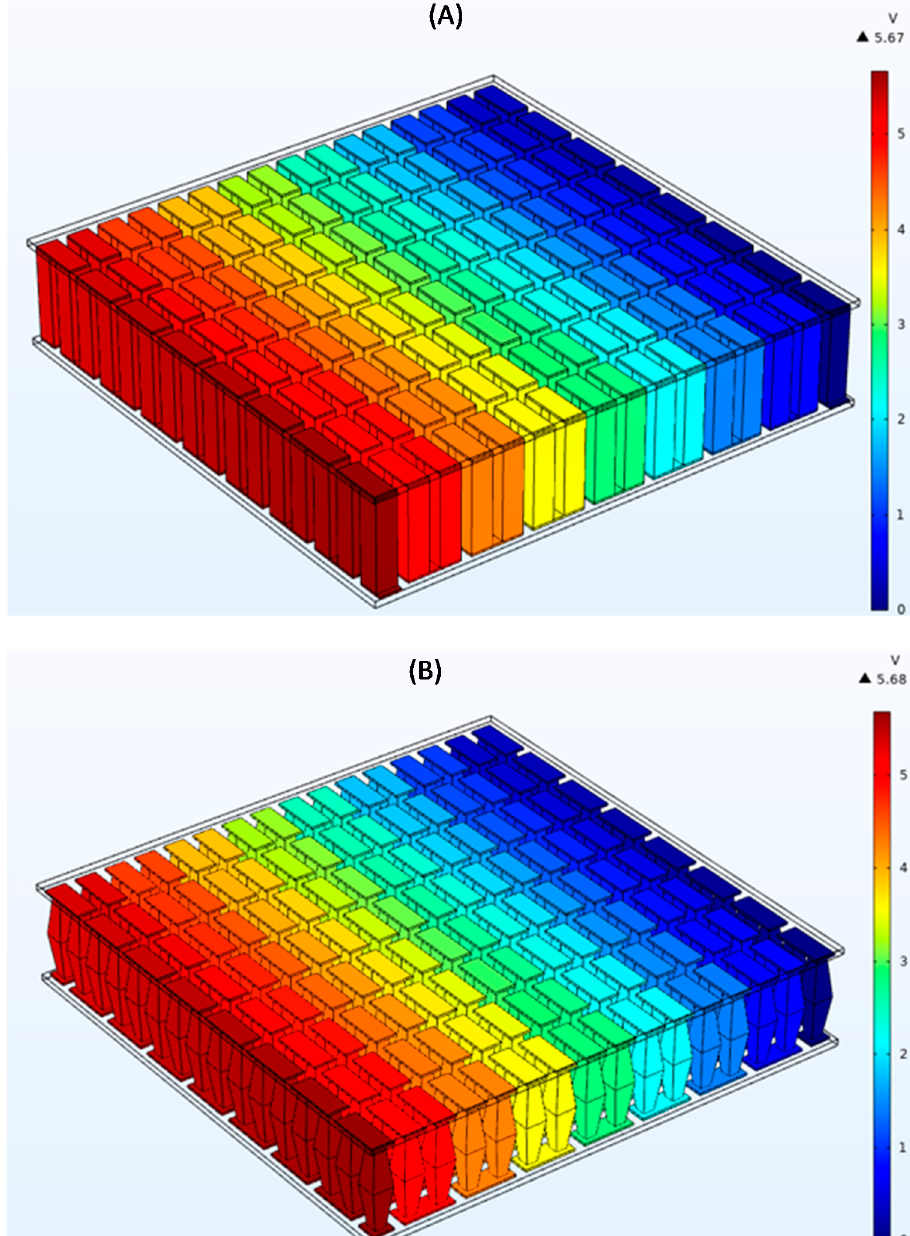
Figure 5. Electrical potential produced in ( A ) Rectangular shape and ( B ) Diamond shape.